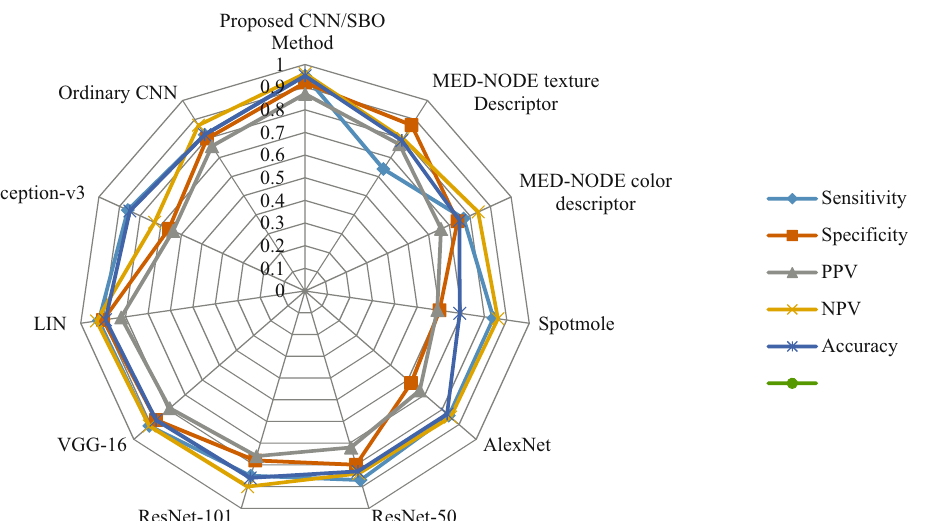
Figure 6: The Radar plot of the classi fi cation rate of skin cancer classi fi cation based on the presented technique and the other methods from the literature and its e ffi ciency is indicated by the confusion